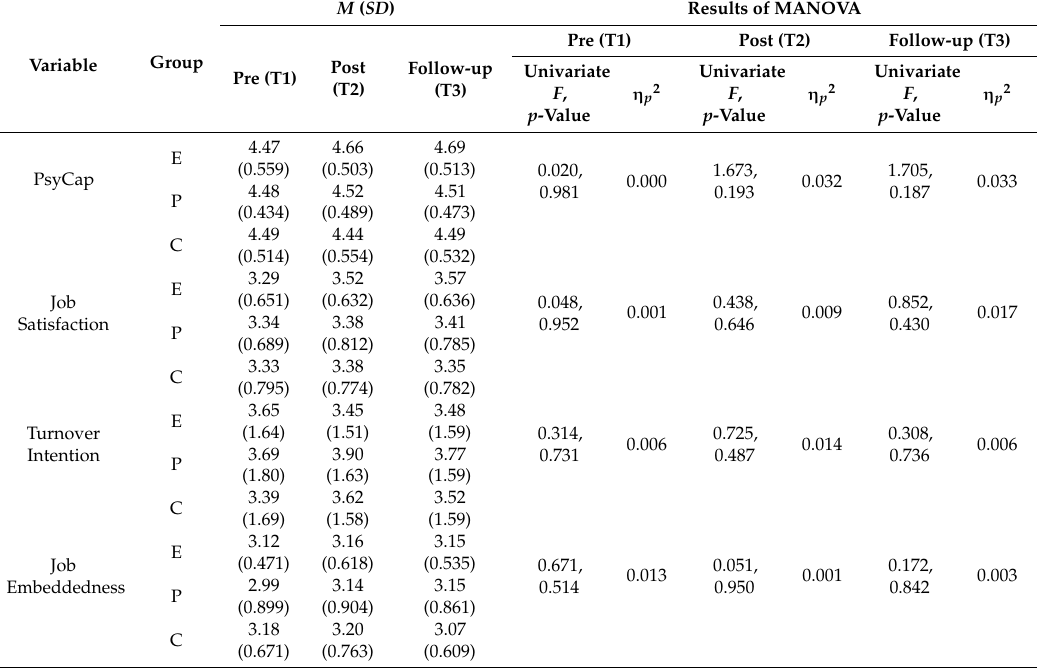
(Table 2); gender, χ 2 (1, N = 104) = 0.98, p = 0.612; age, χ 2 (3, N = 104) = 4.51, p = 0.608; job tenure, χ 2 (4, N = 104) = 12.81, p = 0.118; education, χ 2 (3, N = 104) = 4.24, p = 0.644; or marriage, χ 2 (3, N = 104) = 3.35, p = 0.764. Table 2. Means, standard deviations, and results of the multivariate analyses of variance (MANOVAs) for study variables at pretest (time 1), posttest (time 2), and follow-up (time 3), comparing experimental, placebo, and control